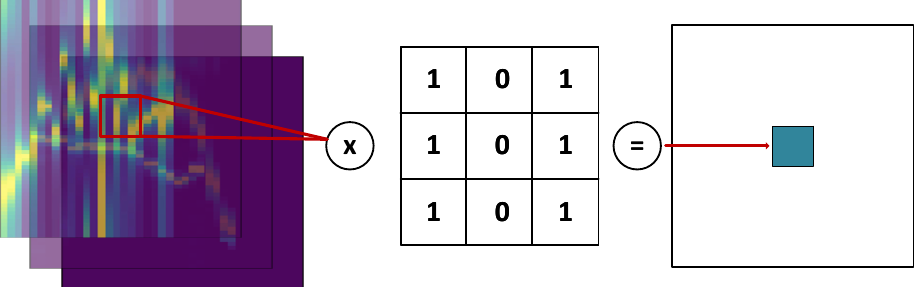
Figure 14. Convolution—principle of